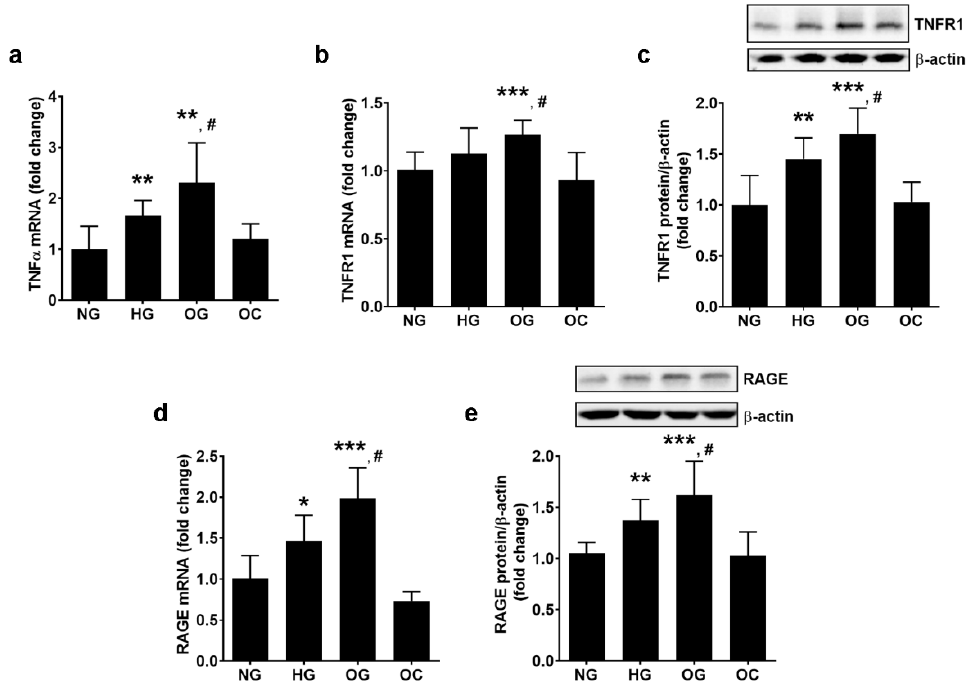
Figure 3. Oscillating glucose stimulates the expression of TNF α , TNFR1 and RAGE in ECs to a greater extent than constant high glucose. Cells were exposed to 5 mM glucose (NG), 25 mM glucose (HG) or alternatively to 5 mM/25 mM glucose (OG) at every 3 h, for 72 h. Cells exposed alternatively to L-glucose or mannitol (using the same protocol as for OG) was considered osmotic control (OC). ( a , b , d ) mRNA levels of TNF α ( a ), TNFR1 ( b ) and RAGE ( d ); ( c , e ) protein expression of TNFR1 ( c ) and RAGE ( e ) in EC lysates relative to β -actin (representative blot and densitometric analysis. All data are expressed as fold change versus NG and presented as mean ± SD. * p < 0.05, ** p < 0.01,*** p < 0.001 vs. NG; # p < 0.05 vs. HG. OG determined the up-regulation of TNFR1 gene expression to a greater extent than HG (1.27 ± 0.11 for OG, 1.12 ± 0.19 for HG and 1.00 ± 0.13 for NG, p < 0.001 for OG vs. NG and p < 0.05 for OG vs. HG; p < 0.001 for all studied groups by ANOVA). Correspondingly, OG stimulated TNFR1 protein expression to a greater extent than HG (1.70 ± 0.25 for OG, 1.44 ± 0.21 for HG, and 1.00 ± 0.37 for NG; p < 0.001 for OG vs. NG and p < 0.05 for OG vs. HG; p < 0.001 for all studied groups by ANOVA, as shown in Figure 3b,c). OG has stimulated RAGE gene expression to a greater extent than HG (1.98 ± 0.37 for OG, 1.47 ± 0.31 for HG, and 1.00 ± 0.29 for NG; p < 0.001 for OG vs. NG and p < 0.05 for OG vs. HG; p < 0.001 for all studied groups by ANOVA) and RAGE protein expression (1.62 ± 0.33 for OG, 1.37 ± 0.20 for HG, and 1.00 ± 0.30 for NG; p < 0.001 for OG vs. NG and p < 0.05 for OG vs. HG; p < 0.001 for all studied groups by ANOVA, as shown in Figure